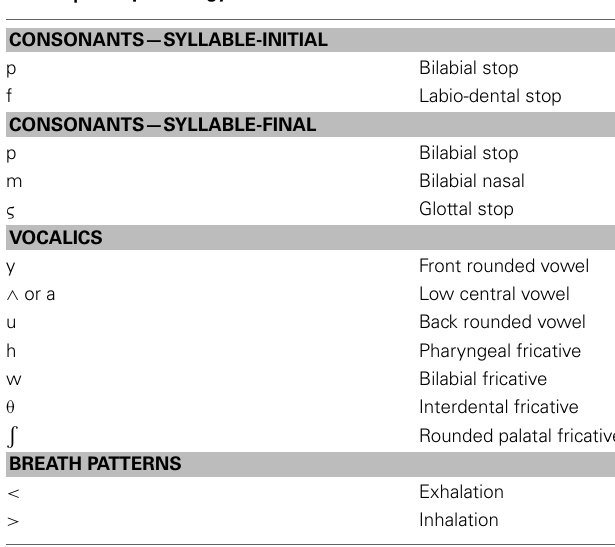
Table 2 | Echo phonology elements in BSL. Table 3 | Examples of syllables with echo